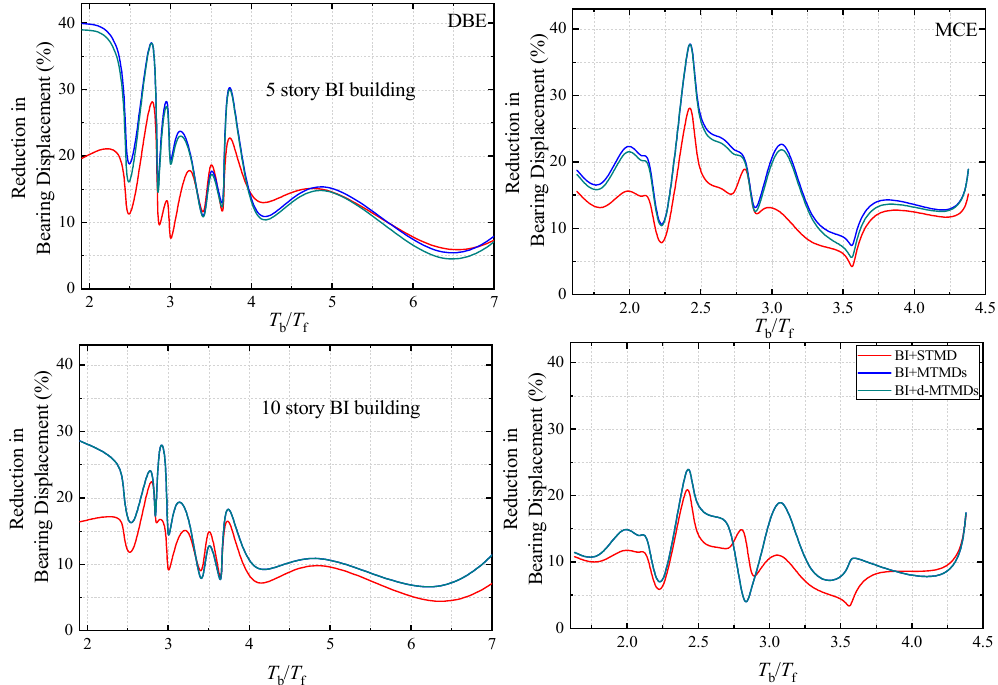
Figure 5. Reduction in average peak bearing displacement of BI and BI equipped by TMD schemes under DBE earthquake ground motions.